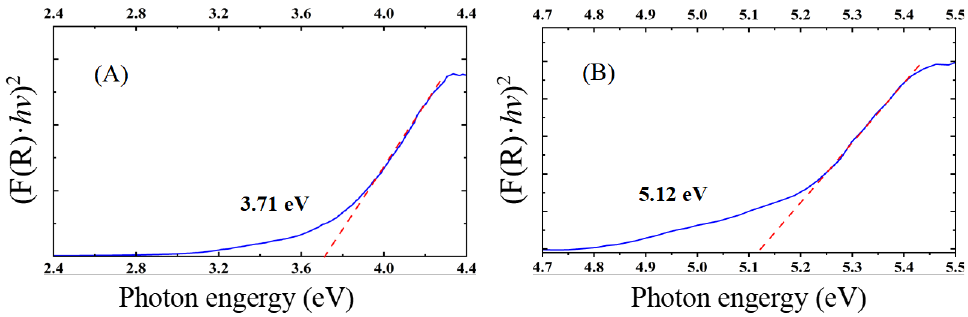
Figure 10. Determination of the maximum absorption peak of ( A ) CC and ( B ) NC corresponding to band gap determined via Kubelka-Munk method.